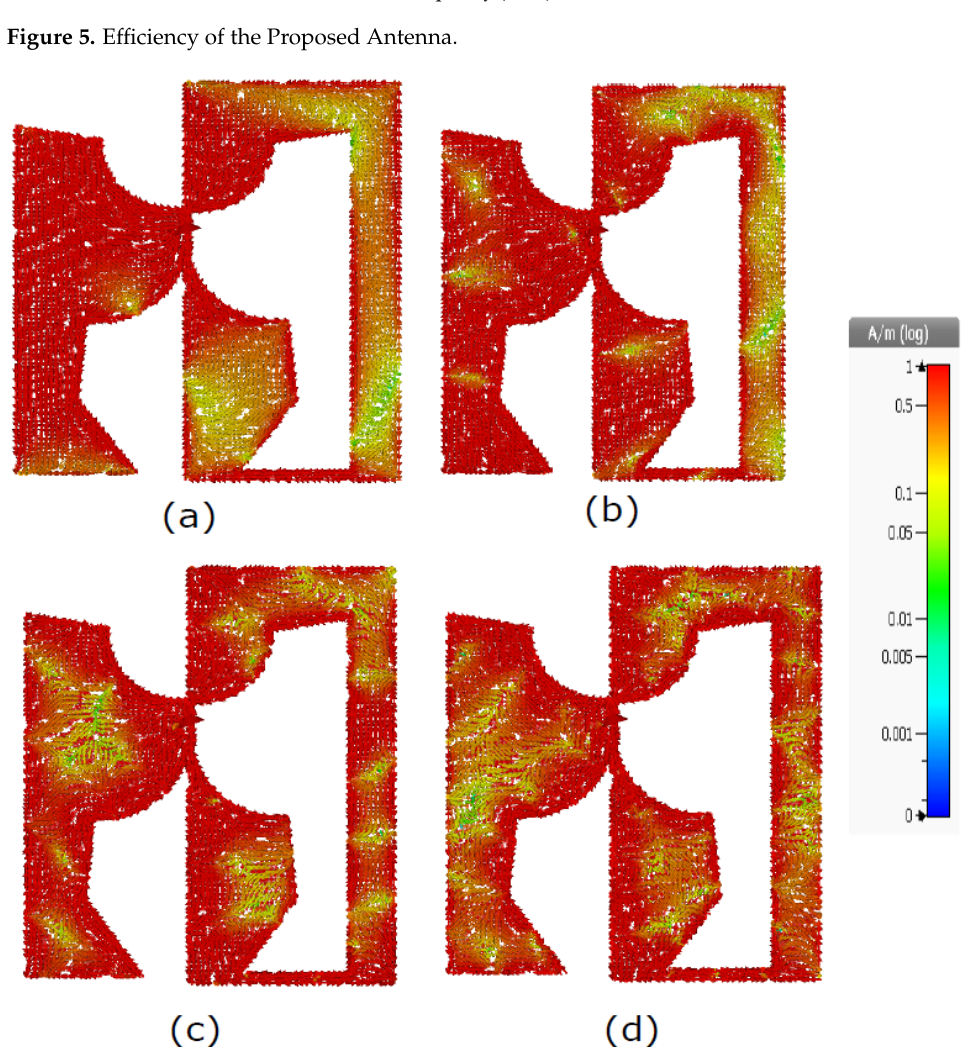
Figure 6. Simulated Surface Current Distribution at ( a ) 2.4 GHz ( b ) 6.5 GHz ( c ) 12.4 GHz and ( d ) 18.4